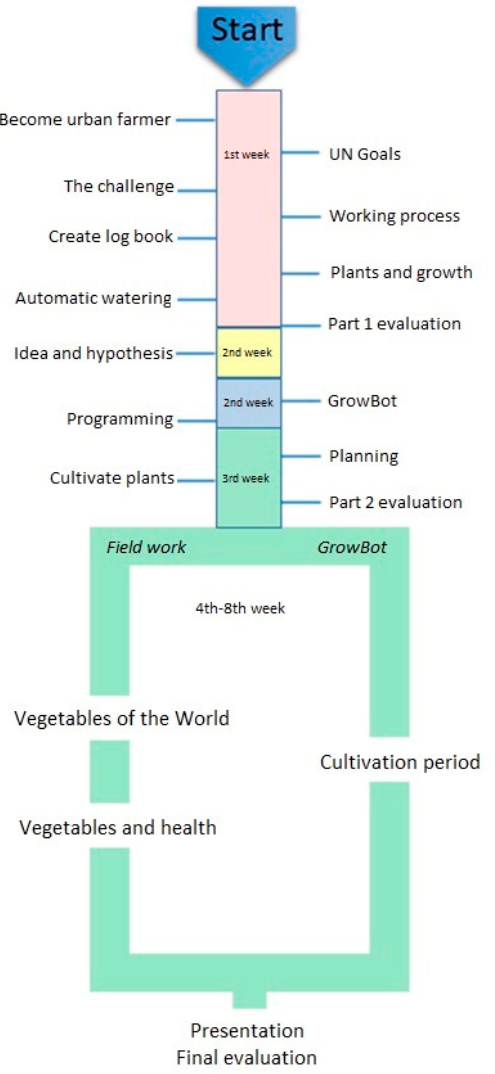
Figure 12. The educational process as it is presented to the teacher with 18 different educational tasks.